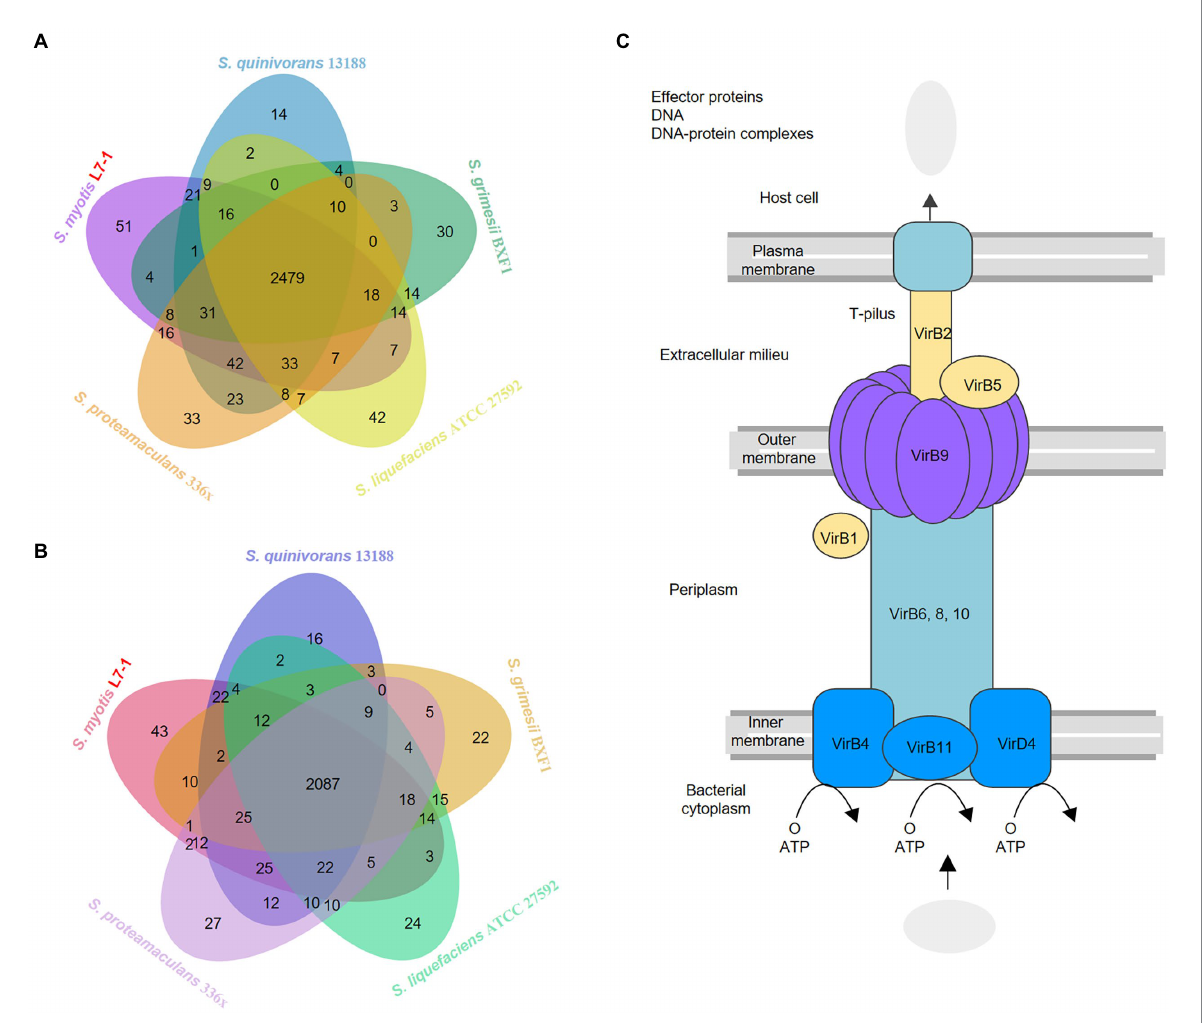
FIGURE 4 Comparative genomics indicates the specific adaptability mechanisms (A) Venn diagram showing the distribution of KEGG genes in the genomes of S. myotis L7-1 and the four reference Serratia strains. (B) Venn diagram showing the distribution of COG genes in the genomes of S.myotis L7-1 and the four reference Serratia strains. www.ehbio.com/test/venn. (C) Pathway map of the type IV secretion system in Serratia L7-1